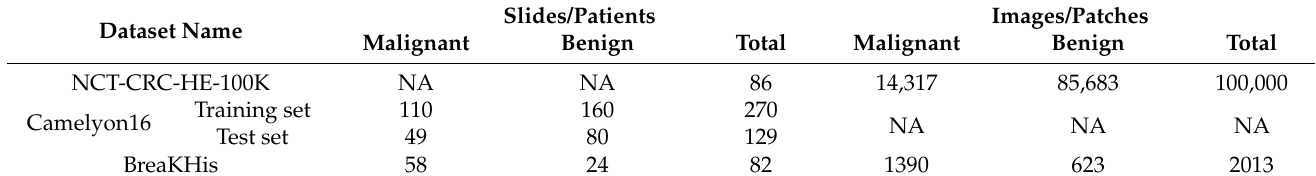
Table 1. Datasets for three types of cancer.